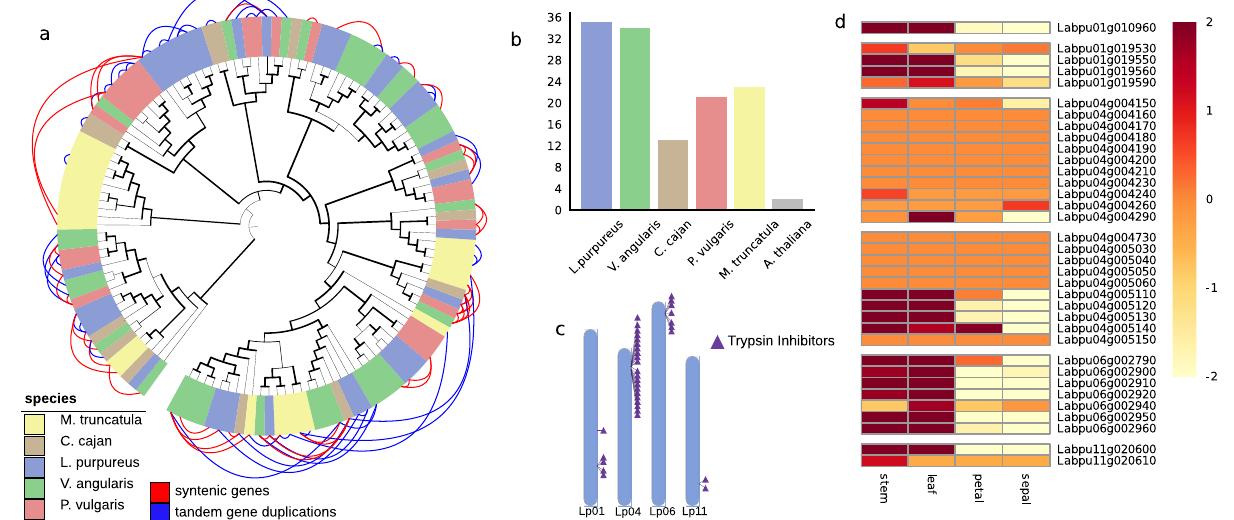
c Organisation of the trypsin inhibitor gene clusters in the lablab genome. d Expression of the trypsin inhibitor genes in four different tissues. Genes in clusters are grouped in the heatmap. The variance stabilising transformed (vst) TPM levels correlate with the intensity of yellow to red colouring. Source data are provided as a Source Data fi le.